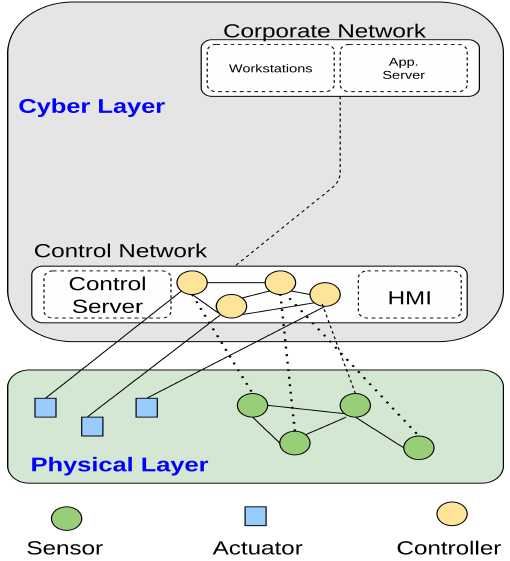
Figure 1. A typical cyber-physical